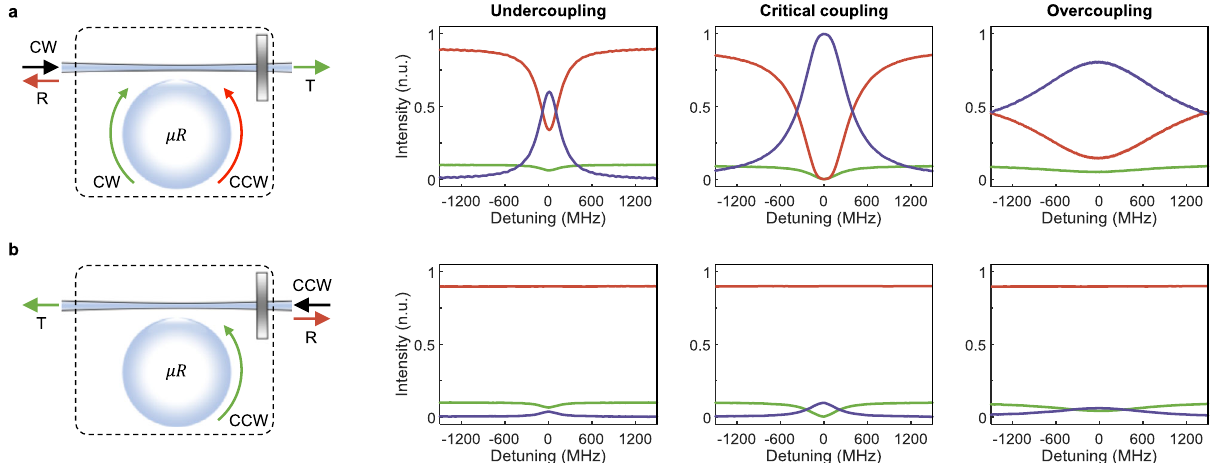
Fig. 4 Chiral perfect absorption on an exceptional surface. Dotted boxes in the left panels in ( a and b ) represent the ES-device composed of a waveguide- coupled microresonator ( μ R ) with an end-mirror with 90% re fl ection and 10% transmission. Black arrows denote the CW and CCW input ports of the ES- device, and red and green arrows represent the corresponding re fl ection and transmission ports. In the case of CW input as in ( a ), the fi eld inside μ R has both CW and CCW components whereas it only has a CCW component for the CCW input as in ( b ). Measured transmission T cw ð ccw Þ (green) and re fl ection R A ¼ 1 (cid:2) R (cid:2) T cw ð ccw Þ (red) spectra and calculated absorption cw ð ccw Þ cw ccw ð Þ cw ð ccw Þ (purple) spectra of the ES-device at the undercoupling, critical coupling and overcoupling regimes for CW (upper panel) and CCW (lower panel) inputs. T cw and T ccw have Lorentzian lineshapes with resonance dips at zero-detuning (ES frequency) at all coupling regimes; R ccw is constant at all frequencies; and R cw exhibits squared Lorentzian spectra. Perfect absorption on the ES with quartic lineshape is observed at the critical coupling for CW input only implying chiral perfect absorption. A cw is at least ten times larger than A ccw , and hence chiral absorption is realized at all coupling